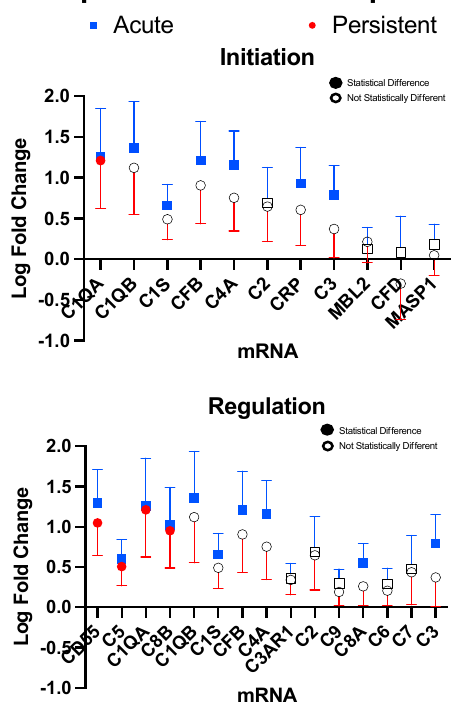
Figure 2. Initiation and Regulation of the complement cascade. Markers are presented for factors that were found for at least one cohort to be above detectable limits. Samples were found to be statistically significant (filled boxes or circles) if they had p -values < 0.05. Error bars represent one standard deviation.